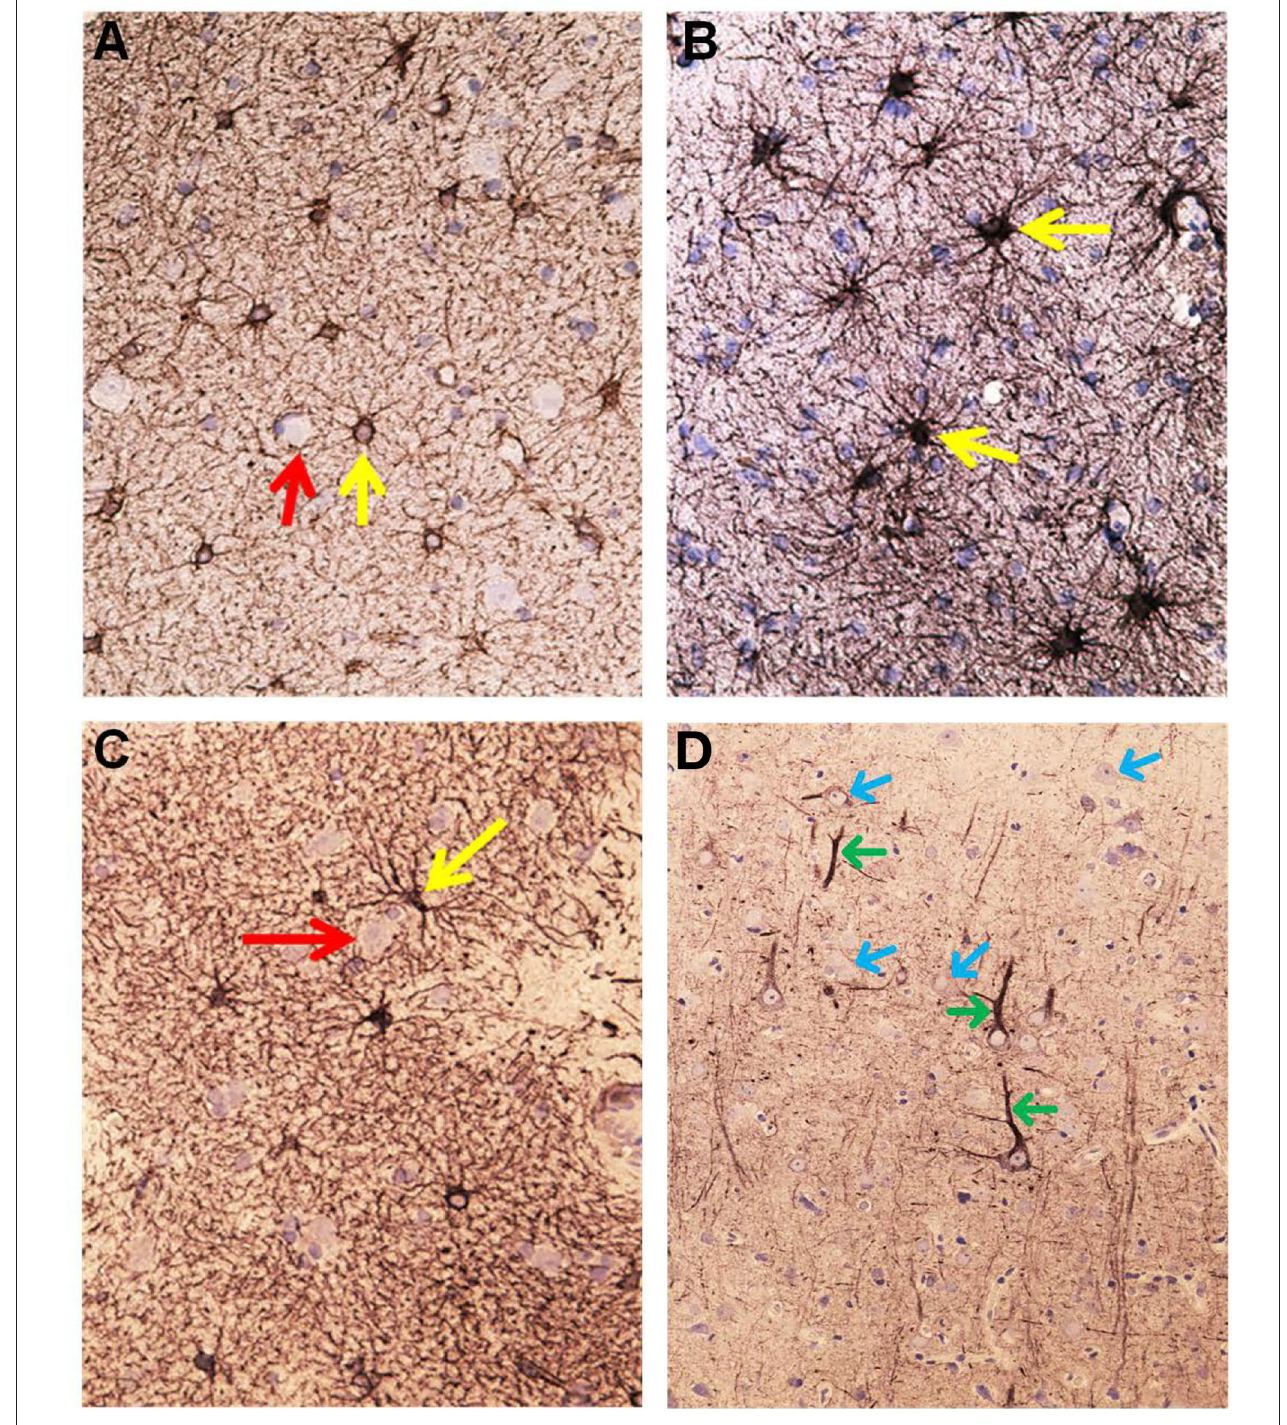
FIGURE 6 | Aspects on the dynamics of astrocytes and neurons in the cerebral cortex of IIH patients. (A) Section of the subpial molecular cortex layer, which is dominated by astrocytes and have only scattered nerve cells. The GFAP-IR astrocytes (yellow arrow) are star-shaped with mainly slender radiating and non-dividing processes. Scattered nerve cells (red arrow) are seen in the neuropil. This illustrates the normal structure of cortex layer 1. (B) The astrocytes in this specimen of layer 1 are hypertrophic and their processes have abundancy of glio-filament (yellow arrow). The density of the GFAP-IR meshwork is increased in (B) as compared to (A) . (C) A dense network of branching and prominently GFAP-IR processes of impressive density. (D) In cortex layers 2/3 of an IIH subject, NF-H-IR expression occurs in damaged or dying neurons (green arrows), while living neurons remain colorless (blue arrows). This indicates neuronal damage in IIH.